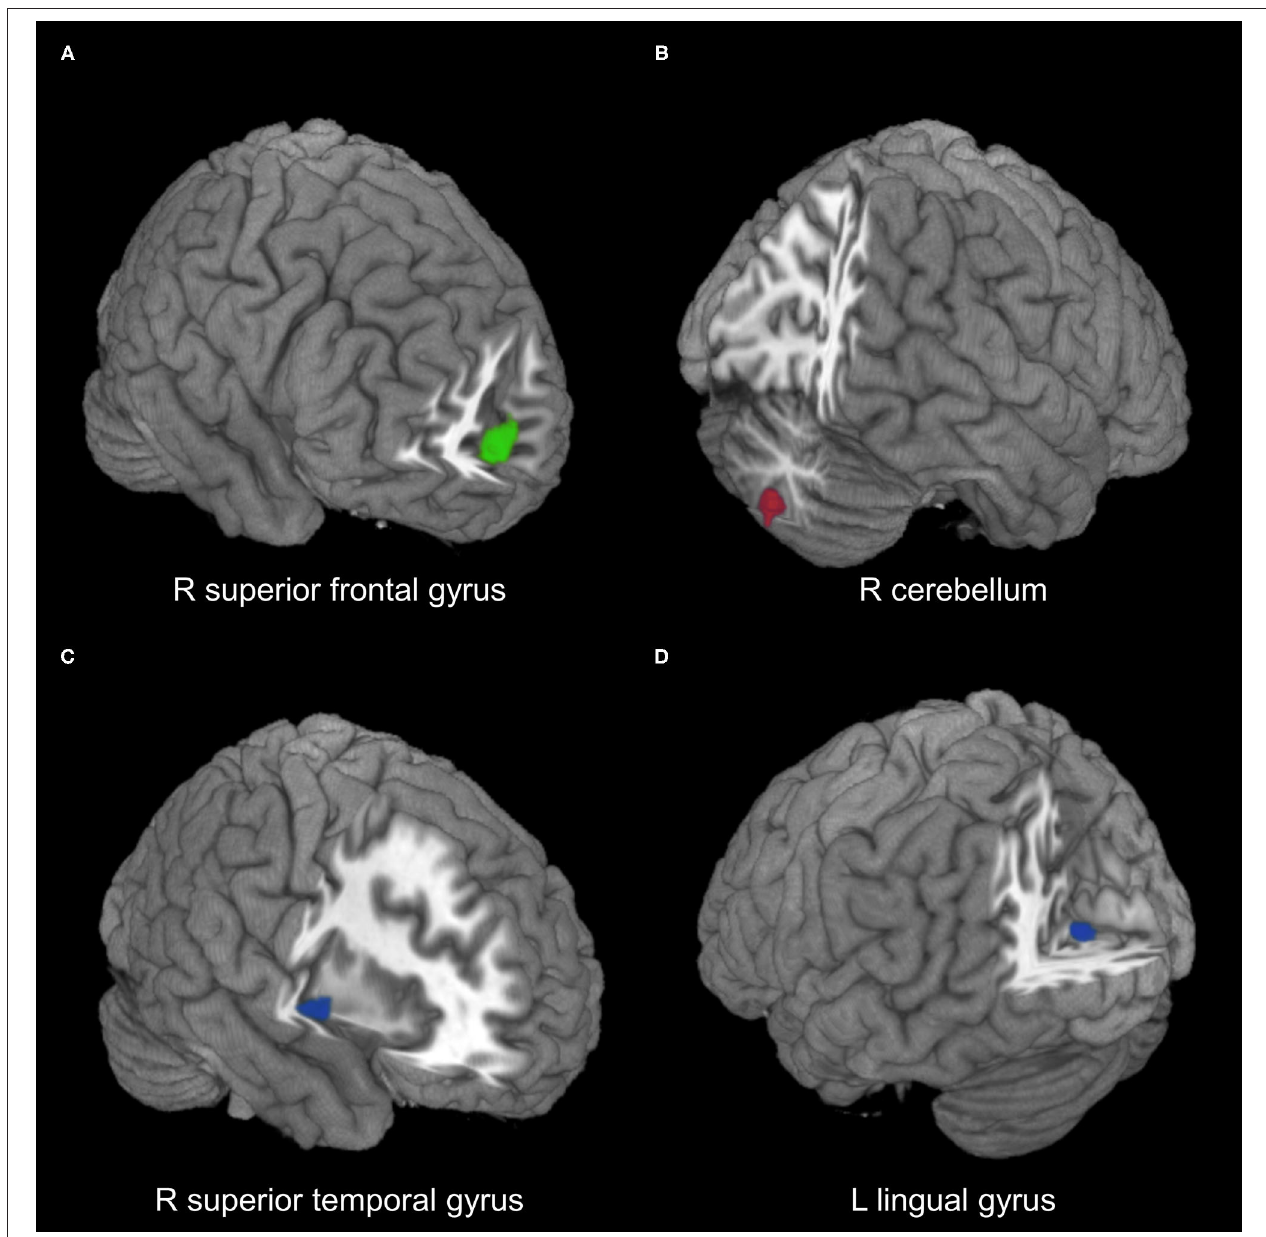
FIGURE 2 | Meta-analysis results of regions with resting-state function alterations in type 2 diabetes mellitus relative to healthy controls. (A) Hypoactivity (green) in combined ALFF/fALFF and ReHo datasets. (B) Hyperactivity (red) in ALFF/fALFF datasets. (C,D) Hypoactivity (blue) in ReHo datasets. ALFF, amplitude of low-frequency fluctuations; fALFF, fractional ALFF; ReHo, regional homogeneity; R, right; L,